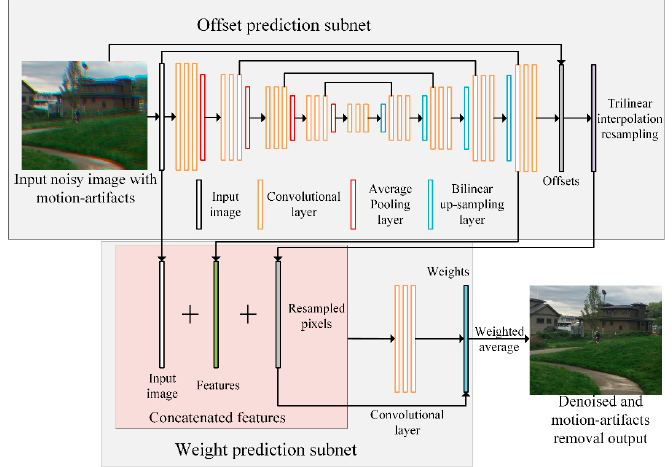
Figure 2. The pipeline and network structure of the proposed DKPNN.